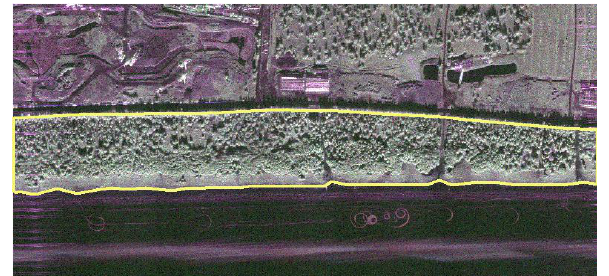
Figure 7. Full polarimetric SAR image of Hailing island Coastal zone was easily extracted by dimensionality reduction and fusion of multi-Features, Figure 8 show the extraction result of coastal zone. As can be seen from Figure 8, the main type of land cover in the coastal zone is low shrubs.